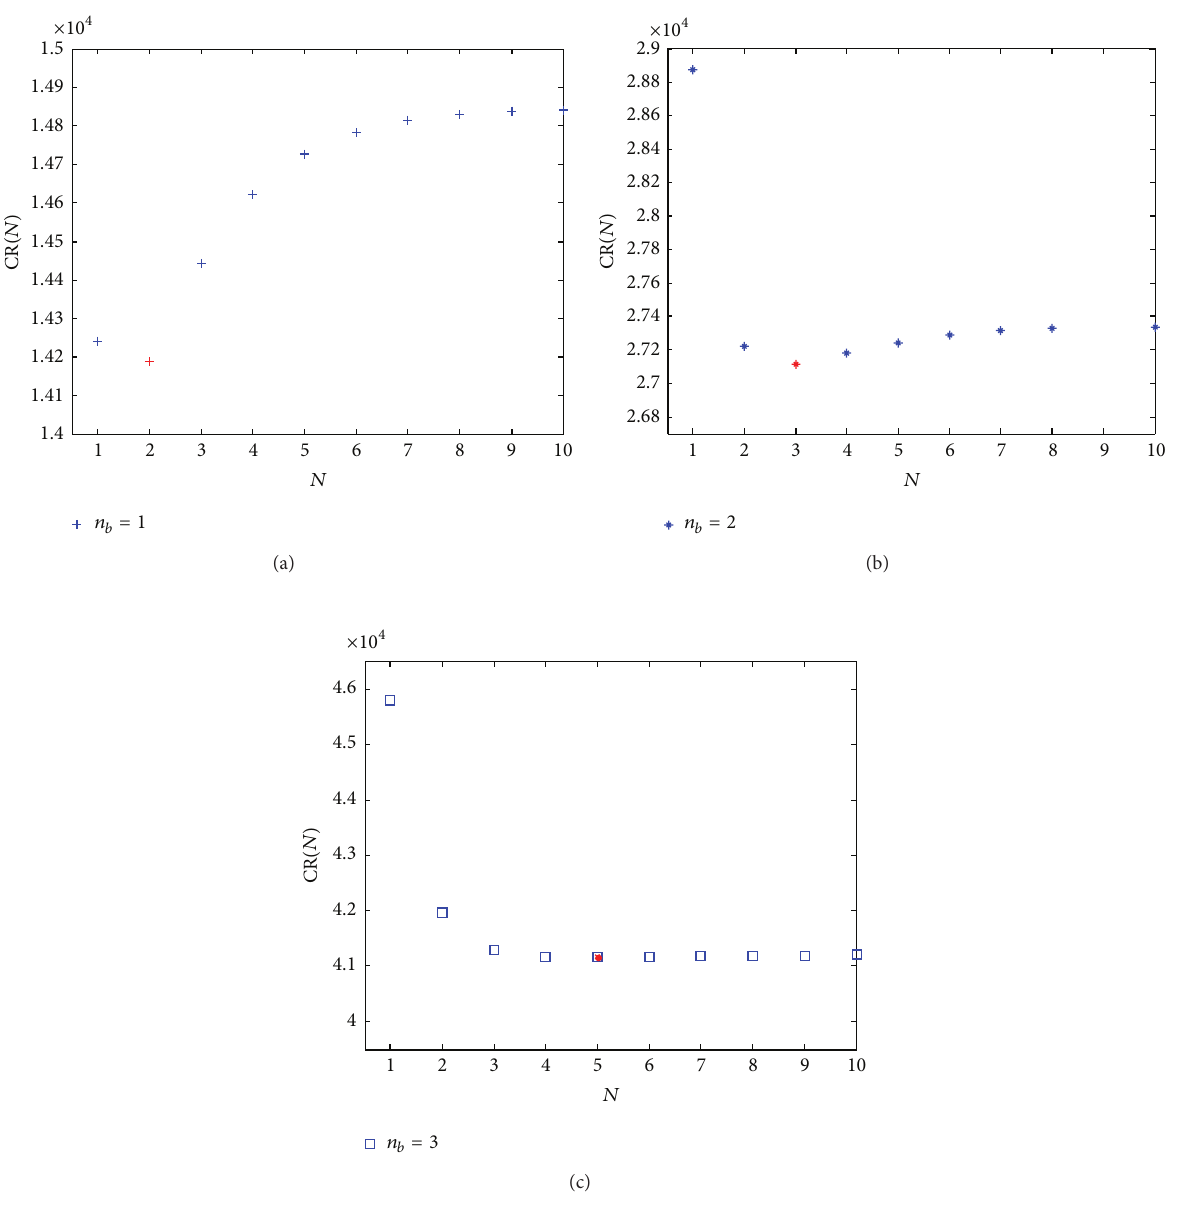
Figure 7: CR (𝑁) for 𝑁 ∈ {1,2,...,10} , 𝑝 = 0.5 and 𝑛 𝑏 ∈ {1, 2, 3}